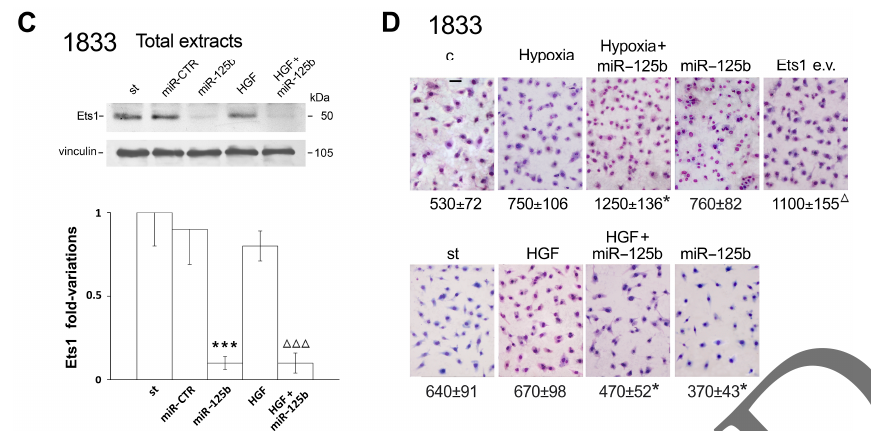
Figure 3. Effects of ectopic miR-125b on Ets-1 protein levels and invasiveness of 1833 cells. ( A ) Total protein extracts were prepared from 1833 cells exposed to 10% or 0.1% FBS, and transfected with miR-125b mimic or with miR-CTR (control) for 24 or 48 h. Western blot and immunoreactions with anti-Ets1 antibody were performed. Vinculin was used for normalization. The experiments were repeated three times. The Western blots underwent densitometry analysis, and the 51/52 kDa bands were considered together. The tables report the means ± S.E. of the fold variations, and the statistical significance of the data: * p < 0.05, ** p < 0.005 versus respective control and starvation values. ( B ) Total protein extracts were prepared from 1833 cells transfected with miR-125b mimic or with miR-CTR (control), and exposed to hypoxia for various times starting 6 h after transfection. The experiments were repeated three times, and the histograms show the means ± S.E. of the relative values, i.e., the fold variations versus miR-CTR value. * p < 0.05 versus miR-CTR; ∆ p < 0.05, ∆∆ p < 0.005 versus respective miR-CTR cells exposed to hypoxia. ( C ) Total protein extracts were prepared from 1833 cells transfected for 48 h with miR-125b mimic or with miR-CTR (control), and exposed to HGF for 24 h. The experiments were repeated three times, and the histogram shows the means ± S.E. of the relative values, i.e., the fold variations versus miR-CTR value: the latter value was similar to that of starvation. *** p < 0.001 versus miR-CTR; ∆∆∆ p < 0.001 versus HGF-exposed cells. ( D ) Some 1833 cells were transfected with miR-125b mimic and were exposed or not to 48-h hypoxia (under 10% FBS) or 24-h HGF (under starvation); other 1833 cells were transfected with Ets-1 expression vector (e.v.). All the cells were seeded in the upper chambers, and Matrigel invasion was assayed in the absence of serum. The experiments were performed in triplicate. After cell count in selected fields, the values of migrated cells in 10 fields were calculated, and shown as the means ± S.E. for the three replicate. * p < 0.05 versus hypoxia or HGF value; ∆ p < 0.05 versus control value. Scale bar = 120 μ m.